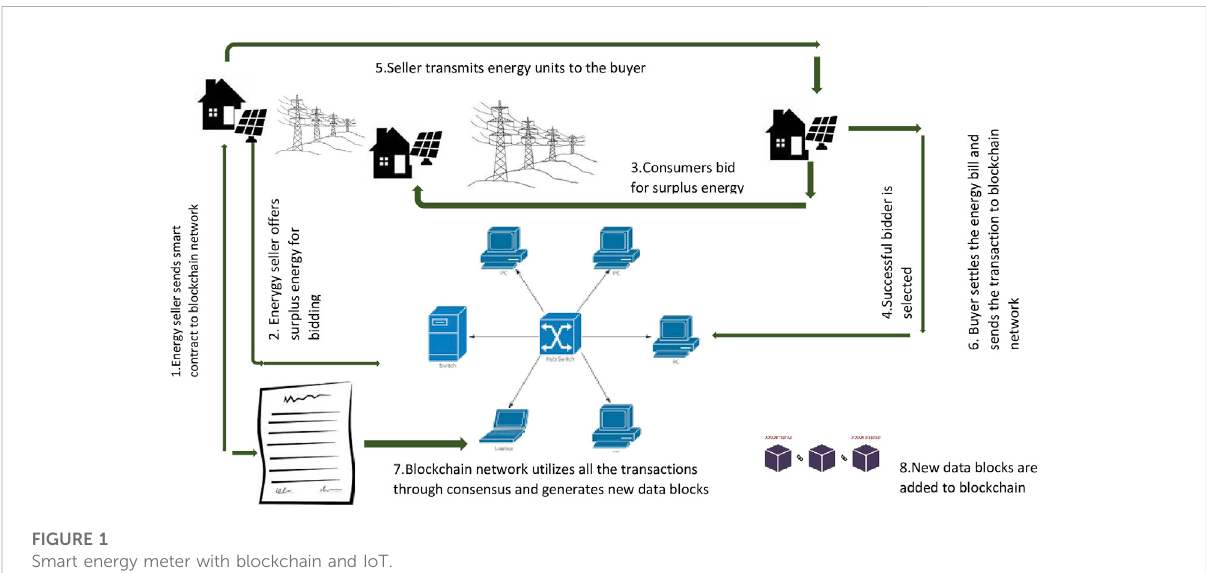
FIGURE 1 Smart energy meter with blockchain and